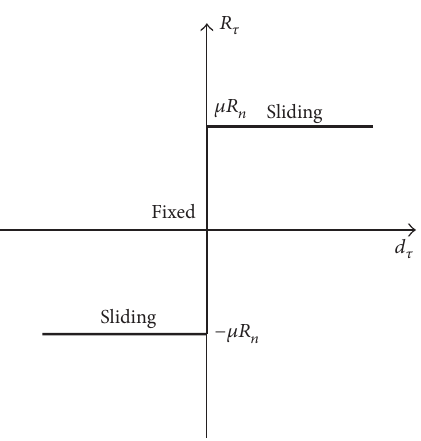
Figure 4: Frictional constraint